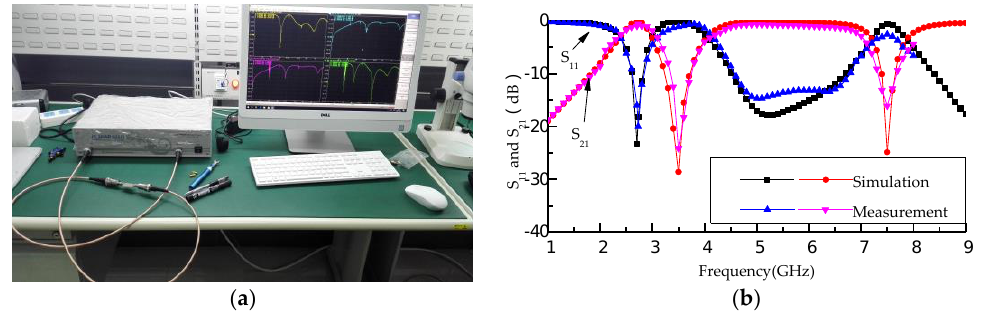
Figure 8. ( a ) The examination photo by Vector Network Analyzer Plannar 804/1 (Copper Mountain Technologies, Indianapolis, IN, USA); ( b ) comparison of the simulation and measurement results of the proposed filter.